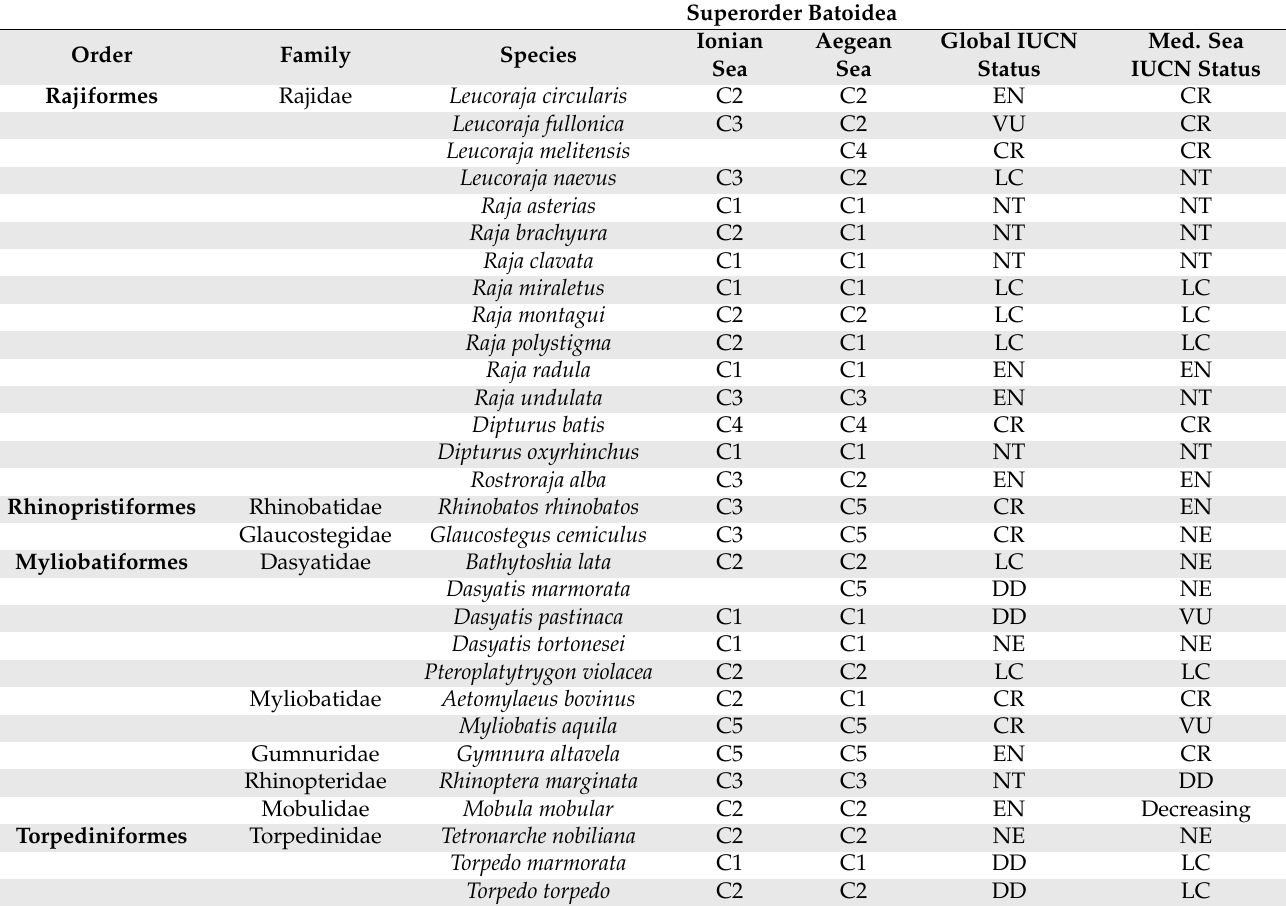
Table 1. Skates and rays of Greek waters divided into five patterns based on their frequency of occurrence from the available literature (C1 = regularly observed; C2 = occasionally observed; C3 = absent from surveys/observations for the past 10 years; C4 = high possibility of misidentification; C5 = local occurrence). The latest global and Mediterranean IUCN Red List assessments are also included (Conservation status categories: CR = critically endangered, EN = endangered, NT= near threatened, LC= least concern, NE = not evaluated, VU = vulnerable, DD = data